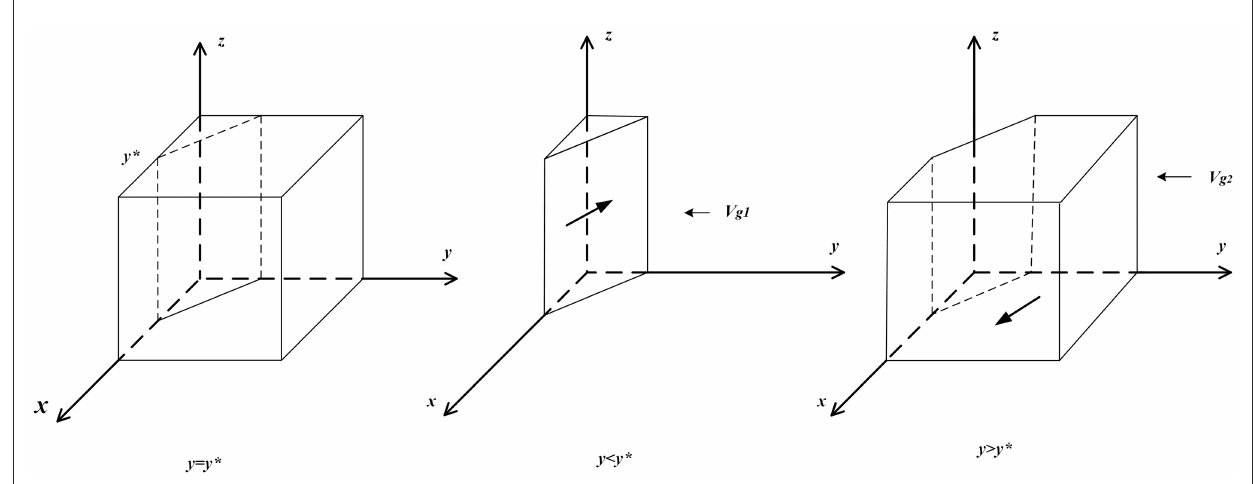
FIGURE4 Phase diagram of governmental departments’